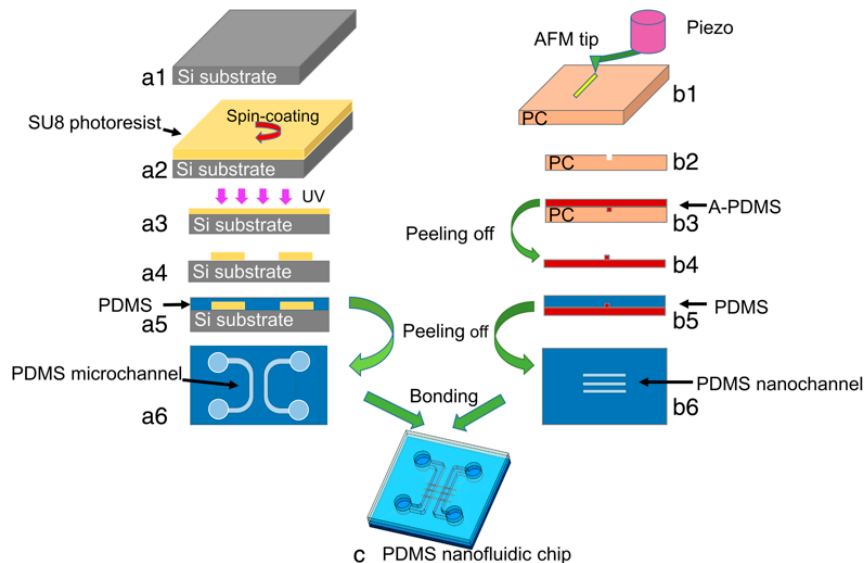
Figure 17. The preparation procedures of nanofluidic chip based on the TBN method: ( a1 )–( a6 ) working steps of microchannel fabrication on a polydimethylsiloxane (PDMS) chip, ( a1 ) silicon sheet used for lithography substrate, ( a2 ) spin-coating of SU8 photoresist on Si substrate, ( a3 ) exposure of the SU8 layer to ultraviolet (UV) light, ( a4 ) obtained convex microstructures, ( a5 ) PDMS coating on microchannel mould, ( a6 ) final PDMS chip with microchannels, ( b1 )–( b2 ) working steps of nanochannel fabrication on a PDMS chip, ( b1 ) AFM tip scratches on polycarbonate (PC) sheet, ( b2 ) obtained nanochannel mould after scratching, ( b3 ) A-PDMS coating on nanochannel mould, ( b4 ) A-PDMS chip with convex nanostructures, ( b5 ) regular PDMS coating on A-PDMS mould, ( b6 ) final PDMS chip with nanochannels, ( c ) PDMS nanofluidic chip after bonding [54] .